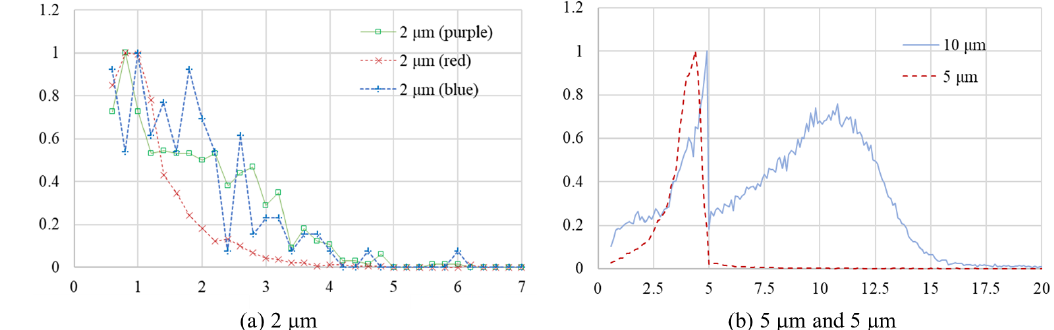
Figure 5. Size distribution estimated by the Plair Rapid-E for different PSL particles with diameters ranging from 2–10µm.